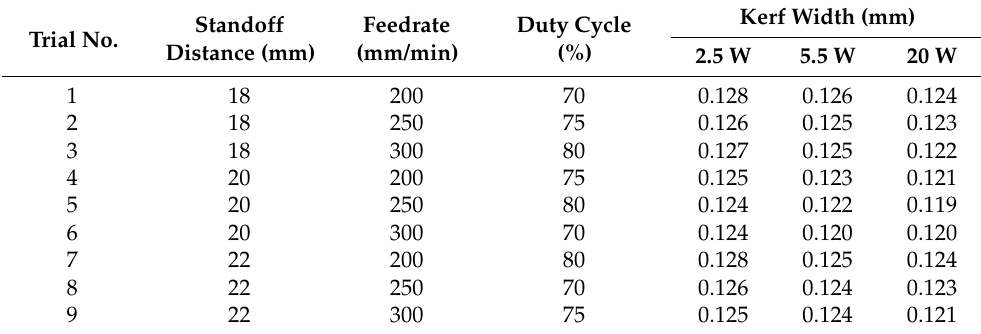
Table 2. Effect of diode laser on kerf width.